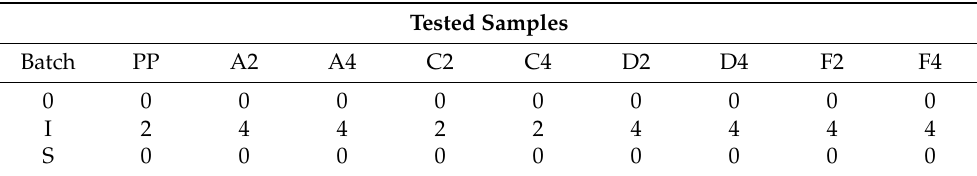
Table 3. Fungal growth on test samples (Method A)—result of visual assessment of samples based on Table